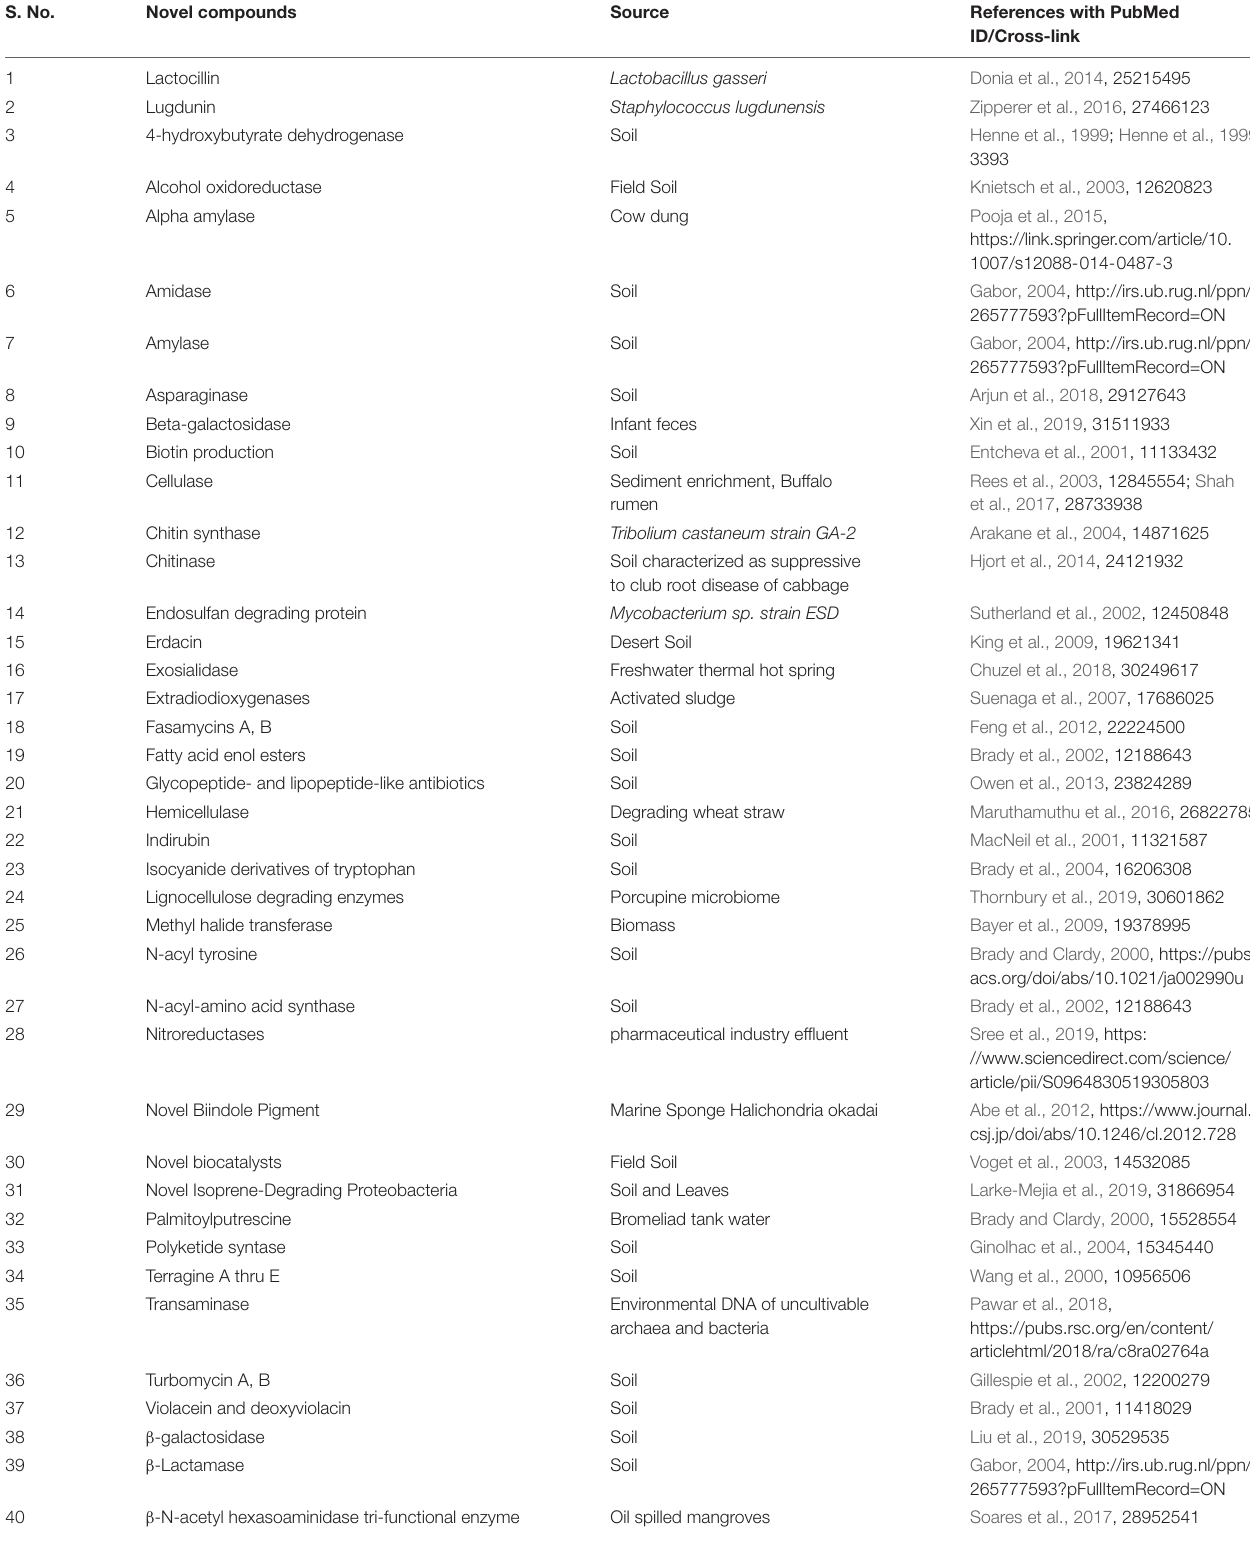
TABLE 4 | List of natural products discovered using a metagenomics approach. S.